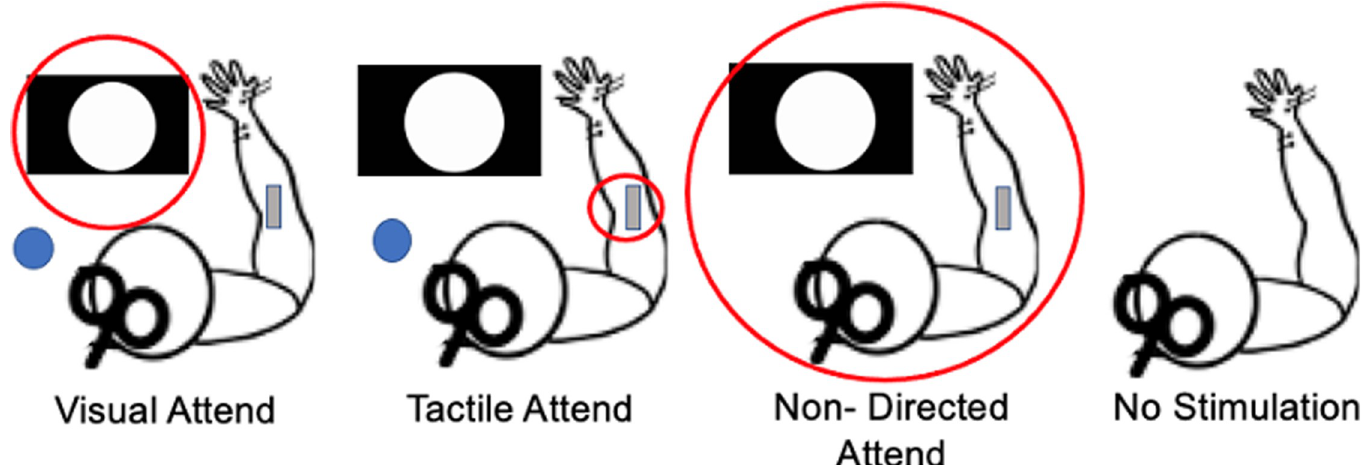
Fig 1. Experimental parameters. Participants were seated in front of a visual stimulus while receiving nerve stimulation and TMS. A) Tactile Attend B) Visual Attend C) Non-directed Attend D) No Stimulation. The red circles represent the experimental environment where the stimulus is present.